Question: Based on the figure, does the quantity rise or fall?
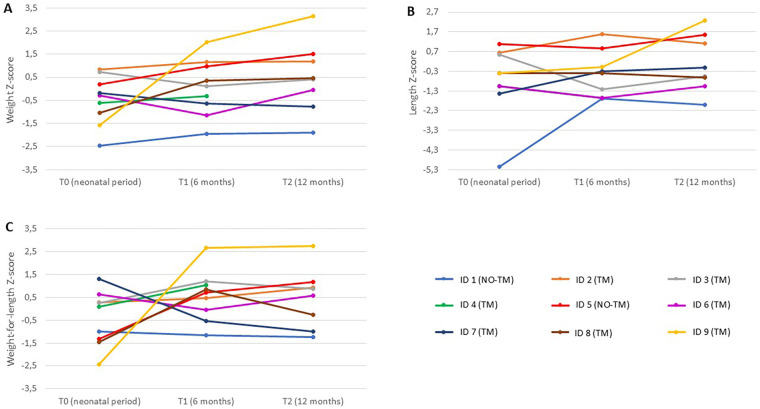
Answer: increasing